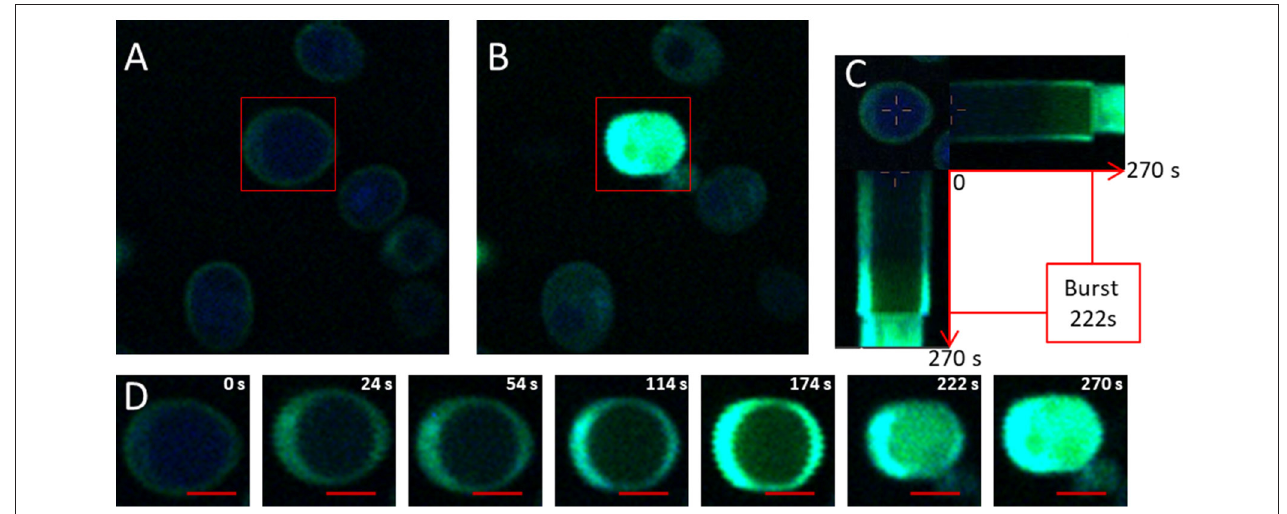
FIGURE 2 | Visualization of 1 O 2 production using APF. (A) Photograph of the initial photo-oxidation treatment induced by the production of 1 O 2 and labeled by APF (4 mg/L) in Saccharomyces cerevisiae cells acquired by fluorescence and two-photon microscopy at 830nm for a light power of 400 W/cm ² . The red rectangle indicates the targeted cell exposed to light stimulation phases of 1.5.10 4 W/cm 2 . (B) Photograph of the end of the photo-oxidation treatment at t = 270s . (C) Horizontal and vertical sections of the temporal evolution of fluorescence in targeted cells during the photo-oxidation treatment. (D) Crop on the targeted cell exposed to a light power of 1.5.10 4 W/cm 2 at 830nm. The red bar represents 2 µ